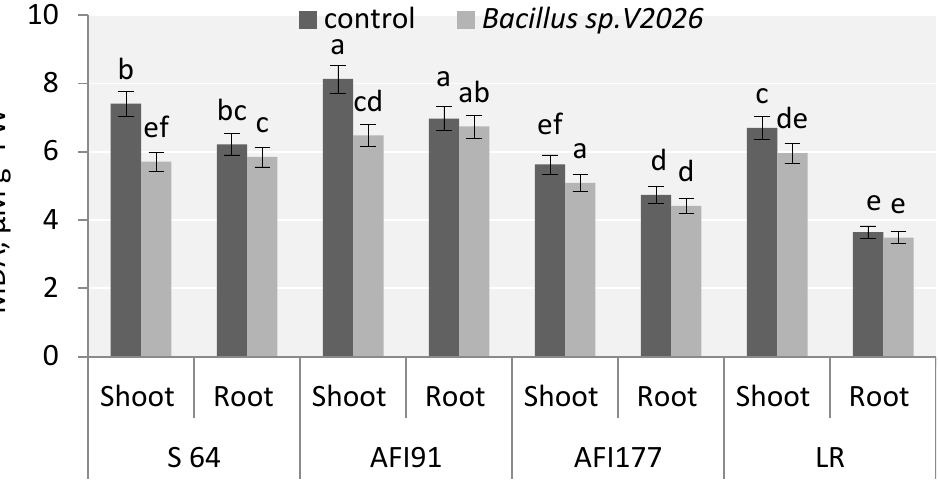
roots of all genotypes involved in the study, ranging from 3.3% in AFI91 to 6.8% in AFI177.